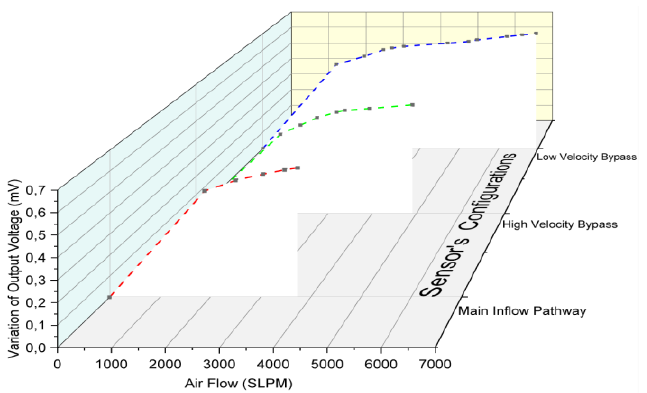
Figure 14. Output voltage variation vs. incoming flow for the three sensor configurations (i.e., for